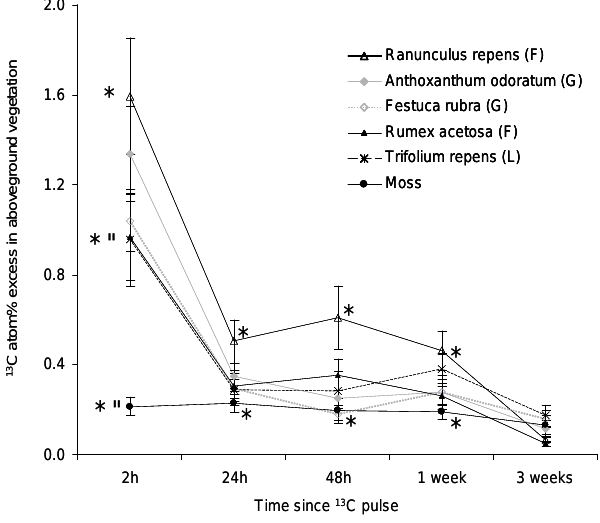
Fig. 2. 13 C atom% excess in leaf tissue across species in relation to restoration management over a 21-day 13 CO 2 pulse-chase period.